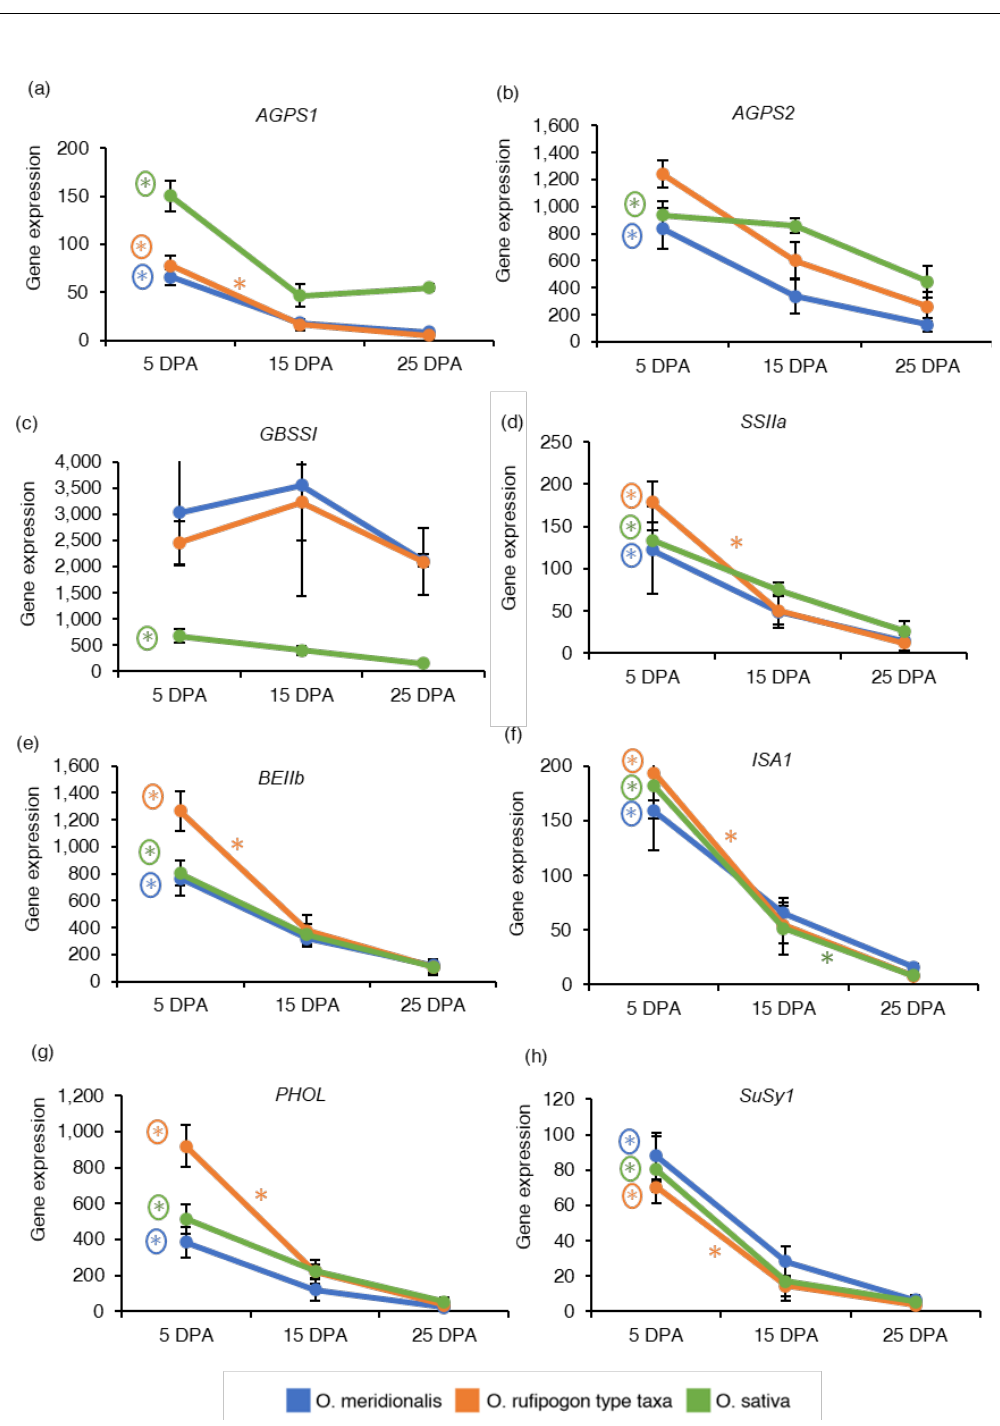
Figure 3. Gene expression of starch and sucrose metabolism-related genes: ( a ) ADP-glucose pyrophosphorylase small subunit 1 ( AGPS1 ); ( b ) ADP glucose pyrophosphorylase small subunit 2 ( AGPS2 ); ( c ) Granule-bound starch synthase I ( GBSSI ); ( d ) Soluble starch synthase IIa ( SSIIa ); ( e ) Starch branching enzyme IIb ( BEIIb ); ( f ) Isoamylase 1 ( ISA1 ); ( g ) Starch phosphorylase ( PHOL ); ( h ) Sucrose synthase 1 ( SuSy1 ). The y-axis represents gene expression based on RNA-Seq analysis and expressed as reads per kilobase of transcript per million reads mapped (RPKM) values. The x-axis represents days post anthesis (DPA). Data are presented as mean ± standard deviation of three biological replicates for O. meridionalis and O. sativa and four biological replicates for O. rufipogon type taxa (except for 25 DPA with three replicates). * symbol above the line between two DPA represents significant differential gene expression and (*) with a circle represents significant differential gene expression between 5 DPA and 25 DP .